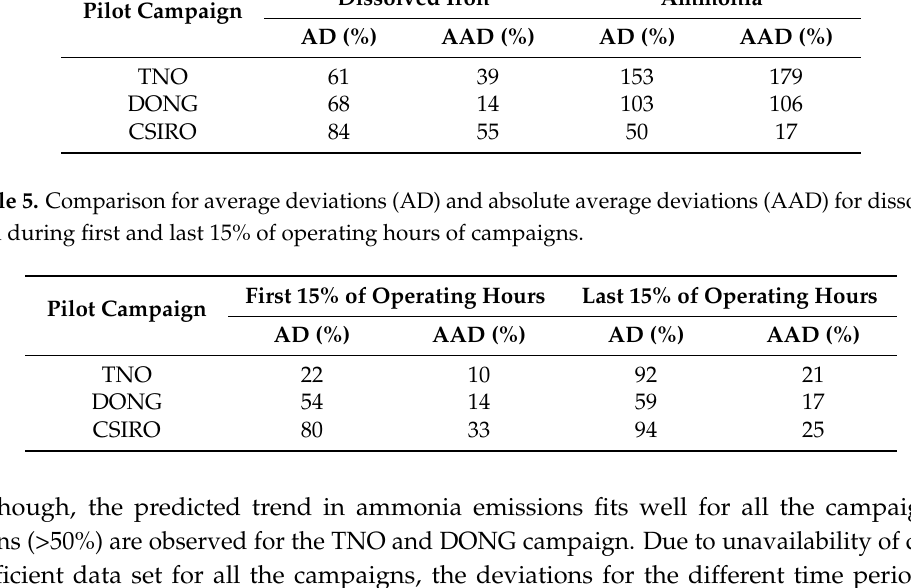
Table 4. Comparison for average deviations (AD) and absolute average deviations (AAD) for the entire campaign duration. Pilot Campaign